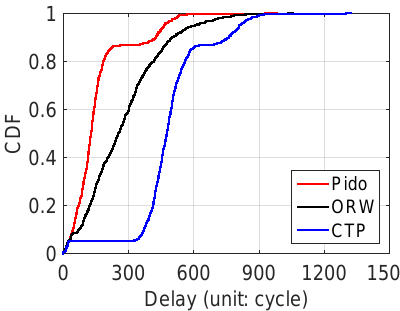
Figure 7. The delay distribution of Pido , ORW and CTP (network size: 225; average under-water time: 360 cycles).